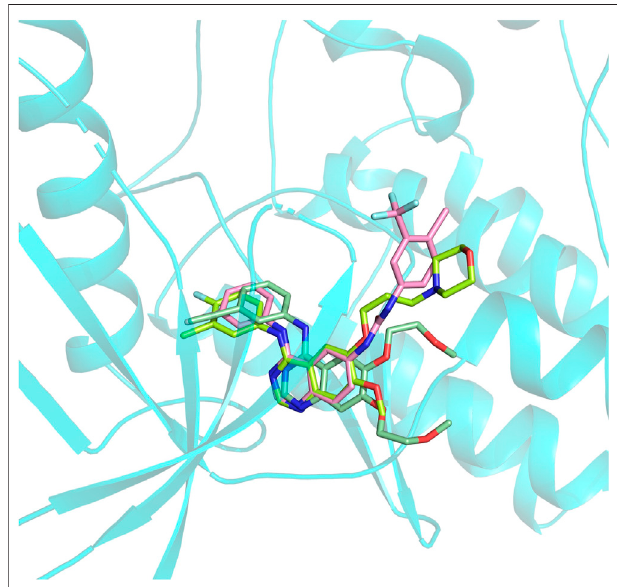
FIGURE 4 | Alignment of initial docking poses of the three systems: erlotinib is marked in pale green, ge fi tinib is in lemon, and Compound 7i is in light